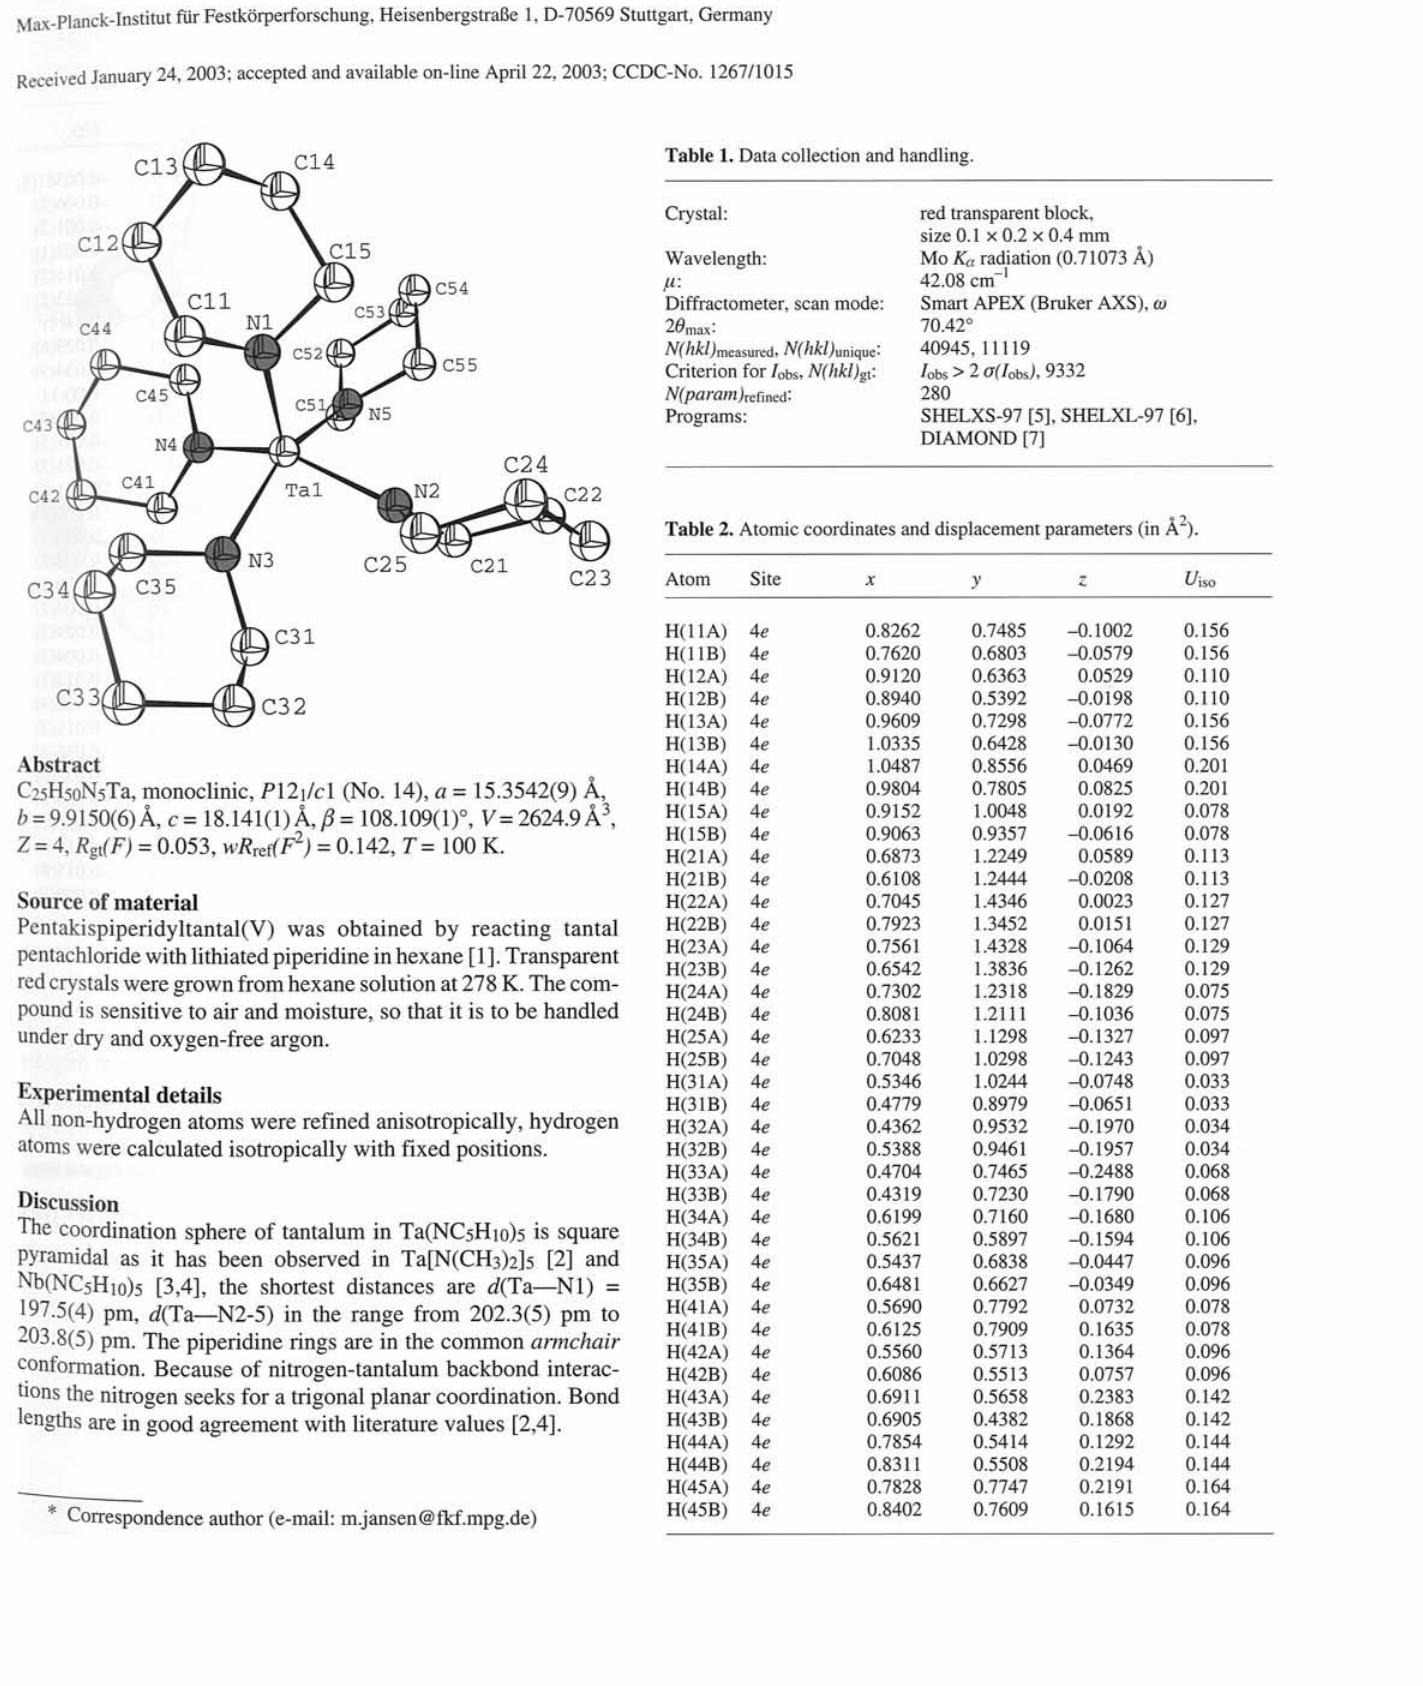
Table 1. Data collection and handling.